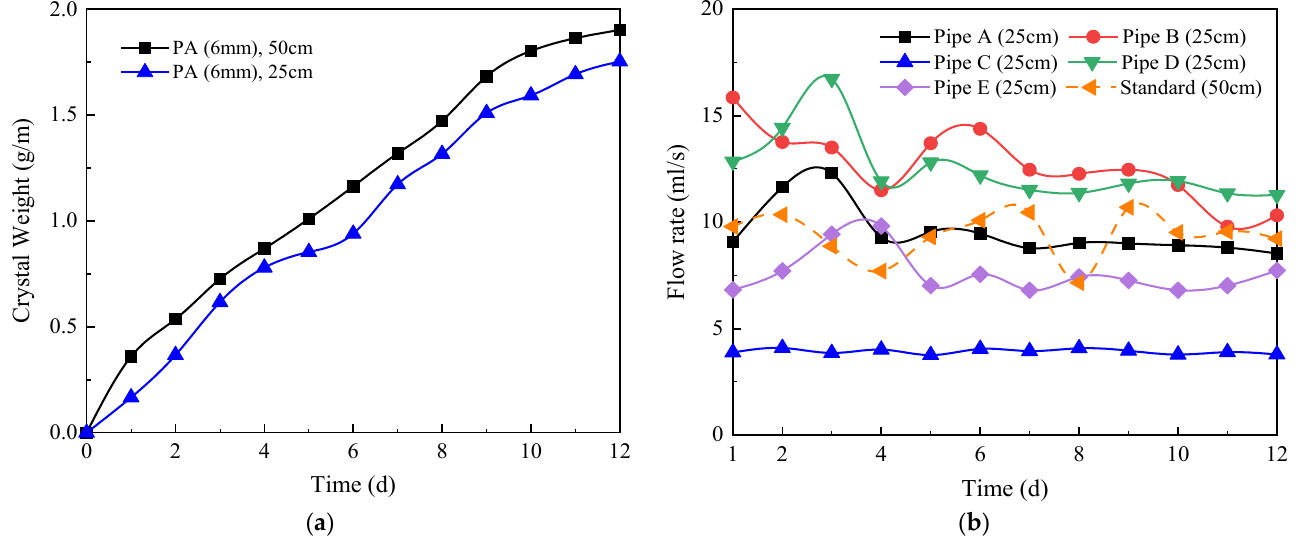
Figure 14. Variation of average crystallization rate and flow rates of circular drainage pipes under different spacing. ( a ) Average crystallization rate curves. ( b ) Flow rate curves.